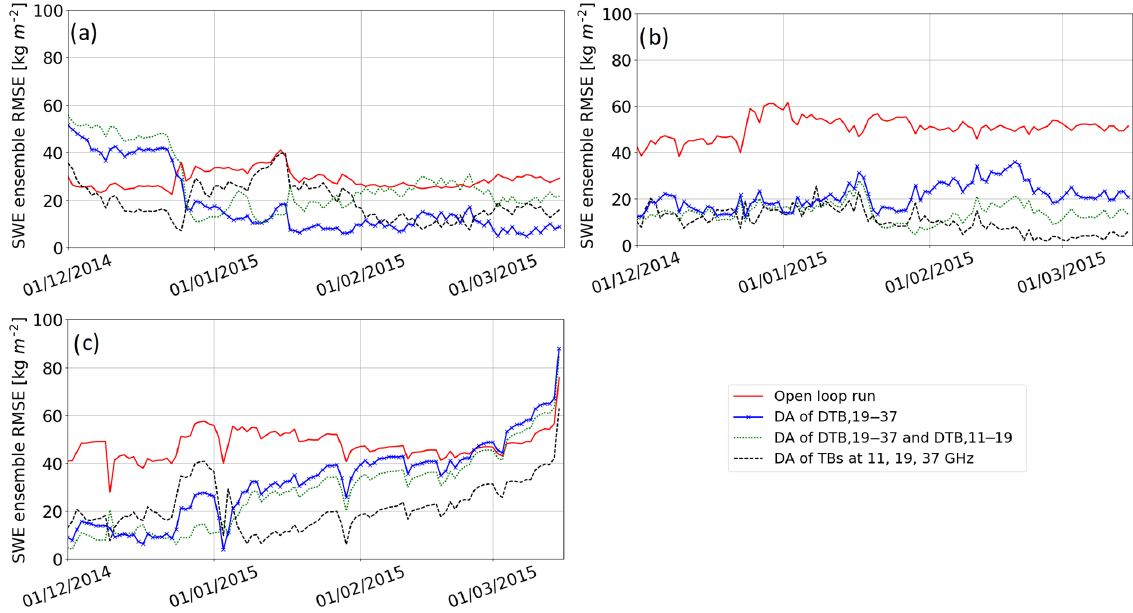
Figure 5. Variations of the SWE ensemble RMSE (Eq. 11) obtained with and without DA for the dry snow period (from 1 December to 15 March). Experiments are performed for (a) Site 12, (b) Site 1, and (c) Site 9, over the winter 2014–2015. The red line is the SWE ensemble RMSE obtained without DA (open loop runs), the blue line is the RMSE obtained with the DA1_TB19-37 experiment, the green dashed line the RMSE with the DA2_TB19-37,TB11-19 experiment, and the black dotted line the RMSE with the DA3_TB_11,19,37